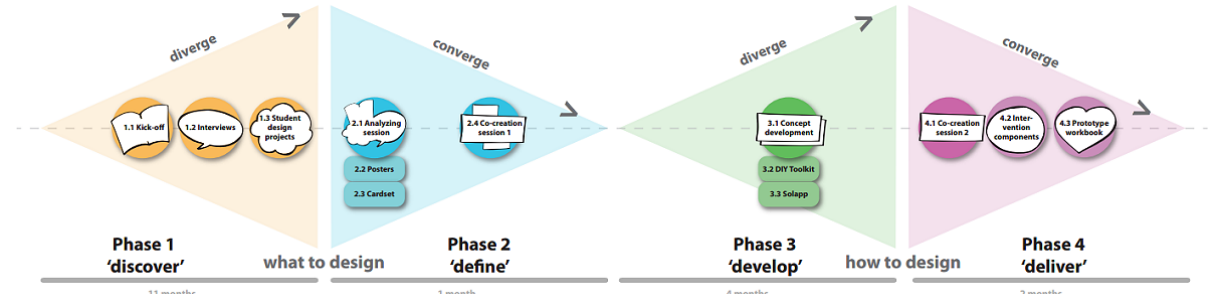
Figure 1. Overview of the co-design development